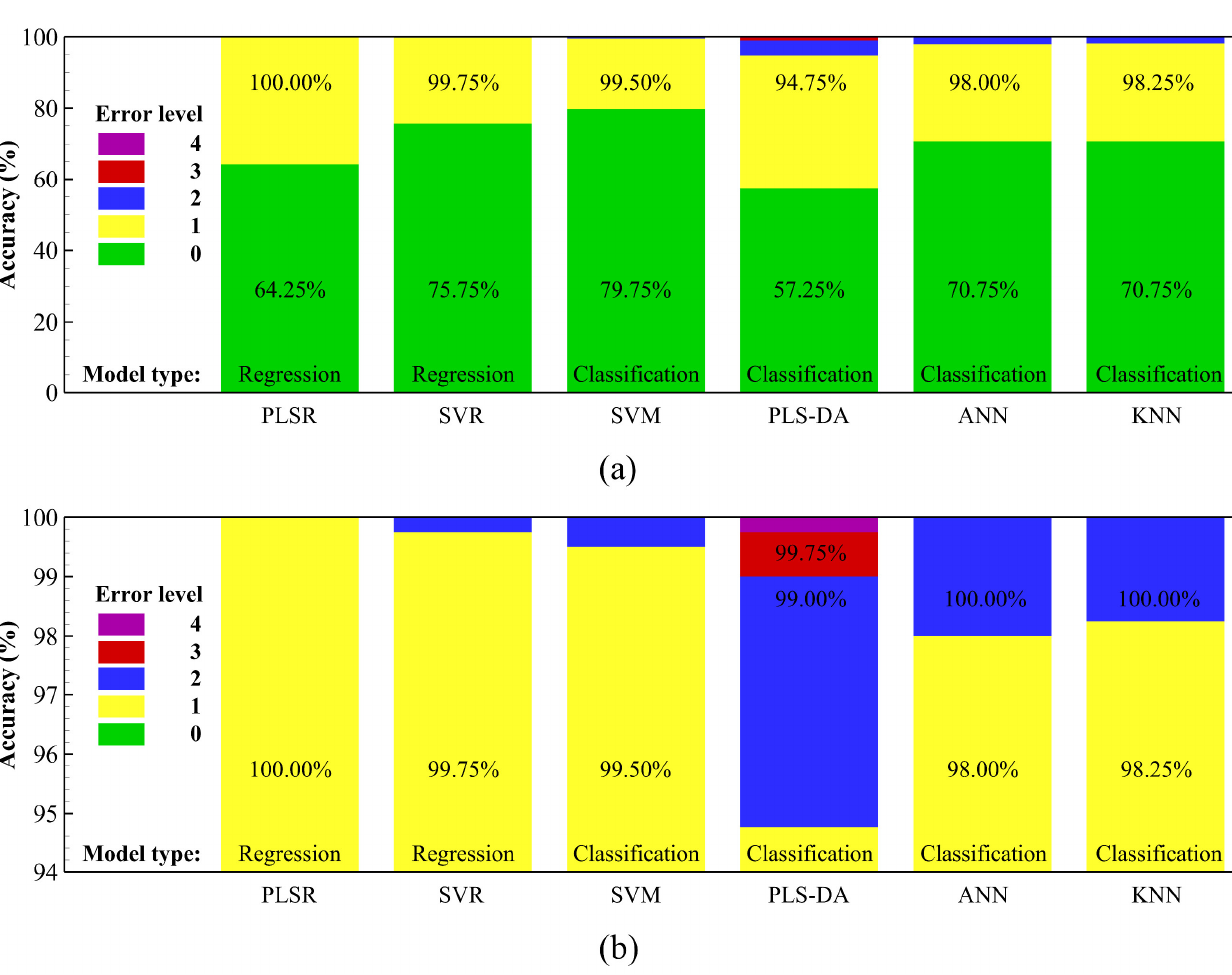
Figure 4. ( a ) The exact accuracy and n-level-error accuracy of the six ripeness evaluation models using averaged spectral data and ( b ) close-up of prediction accuracy.